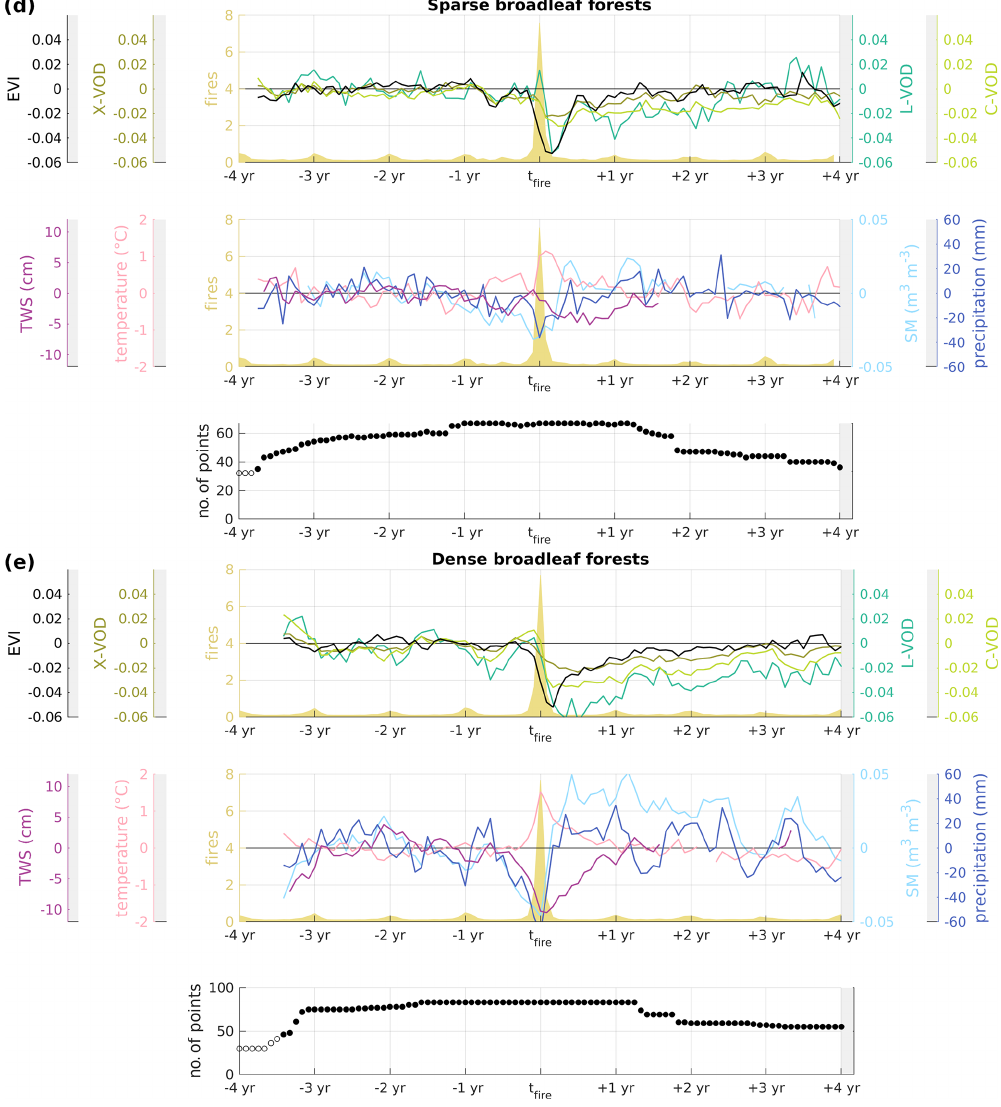
Figure 5. Time series of the number of fires and anomaly time series of EVI; X-, C-, and L-VOD; P ; SM; TWS; and T , shifted on the fire date, for the following biomes: (a) grasslands and croplands, (b) savannas and shrublands, (c) needleleaf forest, (d) sparse broadleaf forest, and (e) dense broadleaf forest. Missing values appear when the number of available points is lower than half the maximum number of points of the biome (empty circles in the lower panel). This is mostly due to snow filtering. Data are kept otherwise (black filled